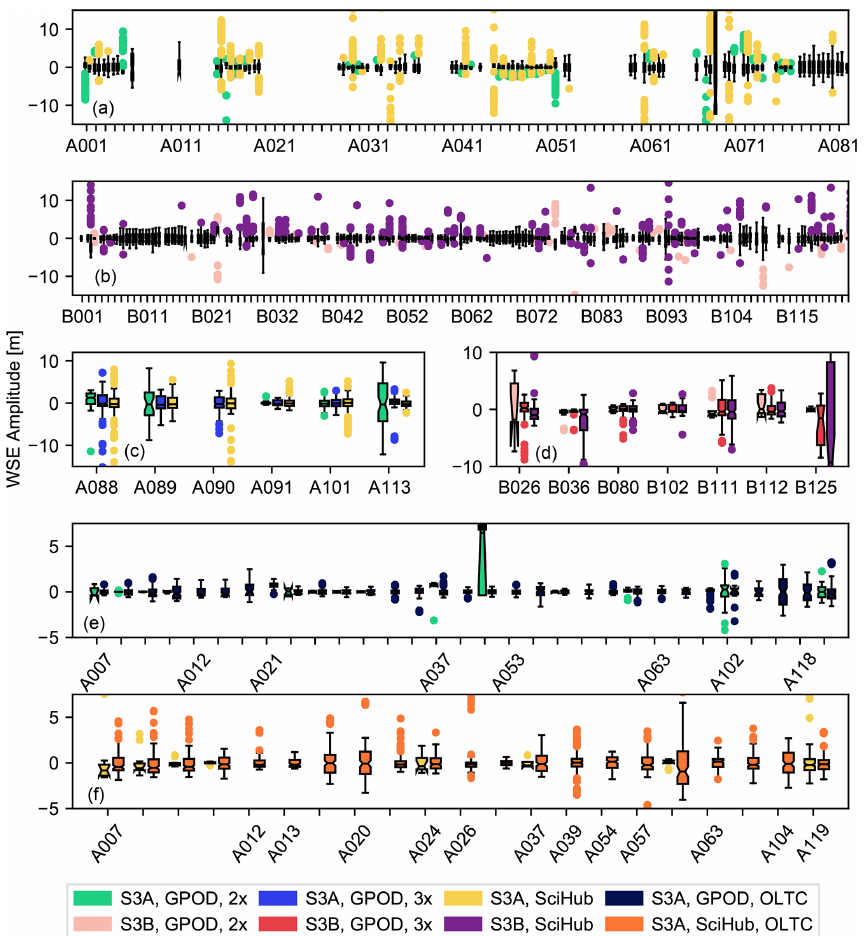
Figure 7. Boxplots of valid water surface elevation (WSE) for each virtual station (VS, along the x axis): (a) all S3A VSs, (b) all S3B VSs, (c) S3A VSs improved with the 3 x receiving window extension, (d) S3B VSs improved with the 3x receiving window extension, and (e) and (f) S3A VSs with observations after the OLTC update only in the GPOD dataset and SciHub datasets, respectively. The gaps in (a) and (b) correspond to the VSs shown in (c) – (f) . The points are WSE outside of 1.5 times the interquartile range (IQR), a common measure to identify outliers, to improve readability; the extreme outliers are cropped out of the plots. See the Appendix for the coordinates of the